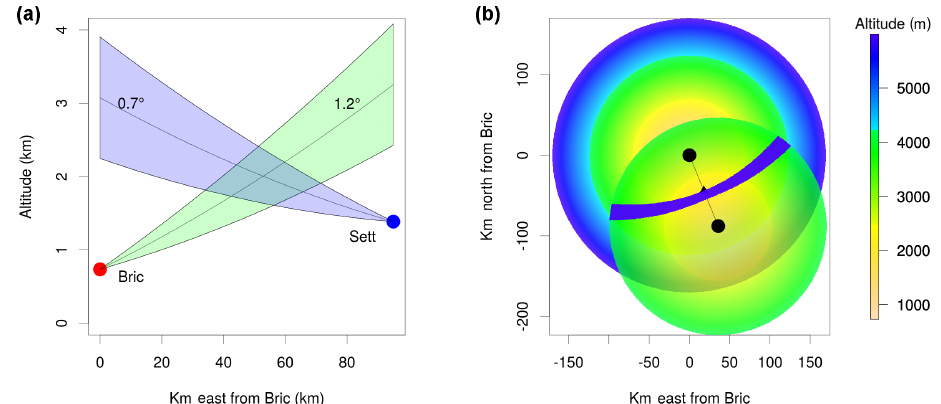
Figure 2. Intersection (a) of Bric della Croce (red point) and Monte Settepani (blue point) radar beams for elevations 0.7 ◦ (Bric della Croce) and 1.2 ◦ (Monte Settepani). The overlapping volume is about halfway between the two radars. Ground projection of the overlapping volume (b) of the Bric della Croce radar (elevation angle: 1.2 ◦ ) and the Monte Settepani radar (elevation angle: 0.7 ◦ ). The Bric della Croce radar is the northernmost. The colors represent the altitude in meters of the main beam center axis. The triangle is located halfway between the Bric della Croce and Monte Settepani